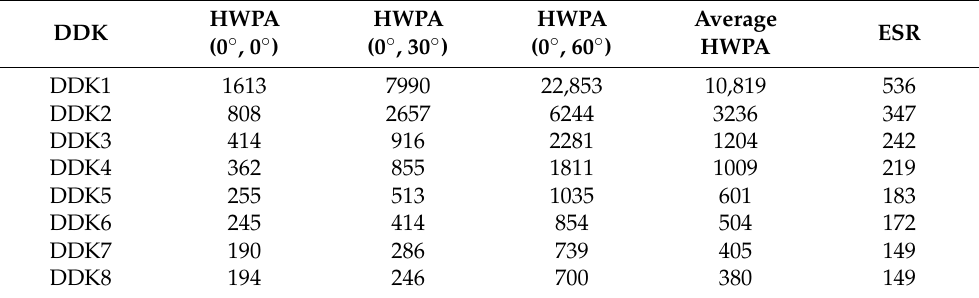
Table 1. The HWPAs and their averages, the ESRs in [11] of 8 DDK filters. The unit of HWPA is thousands of square kilometers, whereas that of ESR is